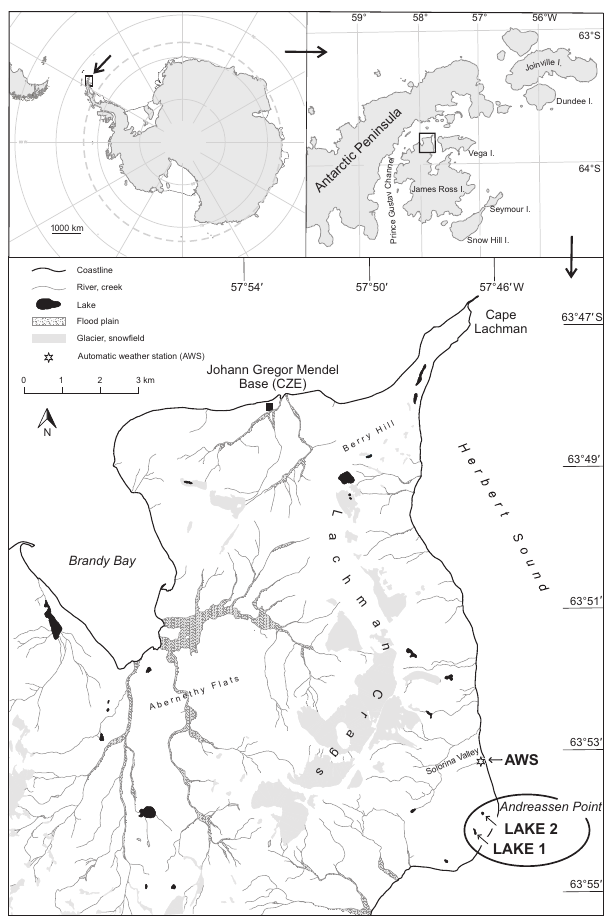
Figure 1. Location of lakes 1 and 2 and air temperature measure- ments (AWS) in the Solorina Valley. The upper inset map shows the position of the study site and James Ross Island in the northeastern part of Antarctic